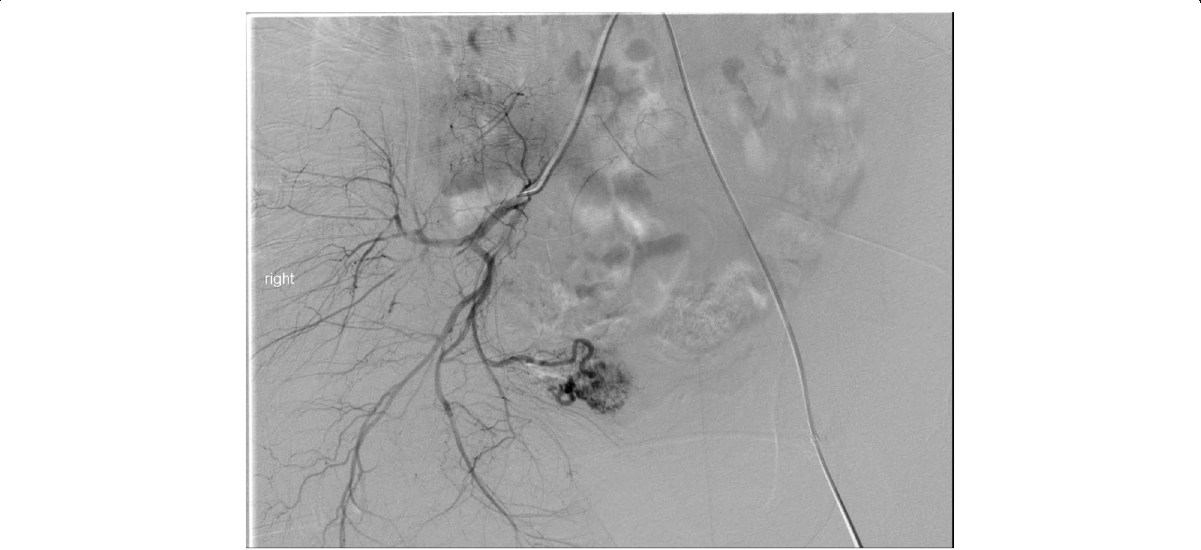
Fig. 7 Selective angiography of the right common iliac artery demonstrates an arteriovenous malformation that corresponds to the flow voids seen on the MRI in Fig. 6